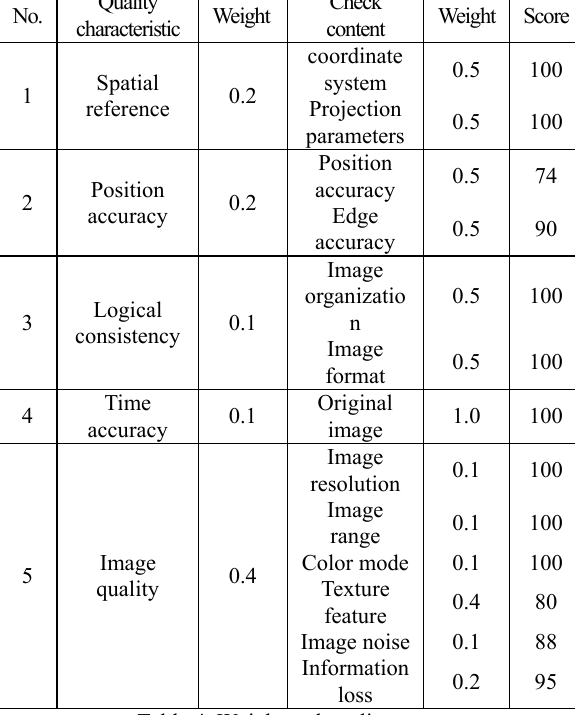
Table 4. Weight and quality